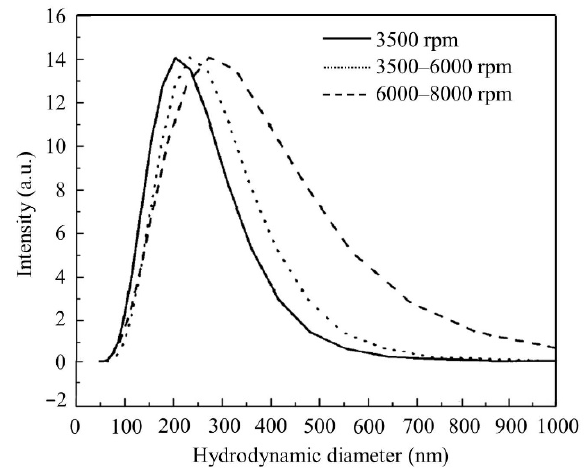
Figure 8. Particle size and distribution of the PAA-AM/St composite.